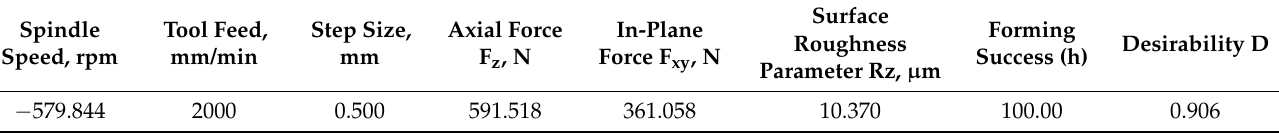
Table 9. The most favourable optimal global